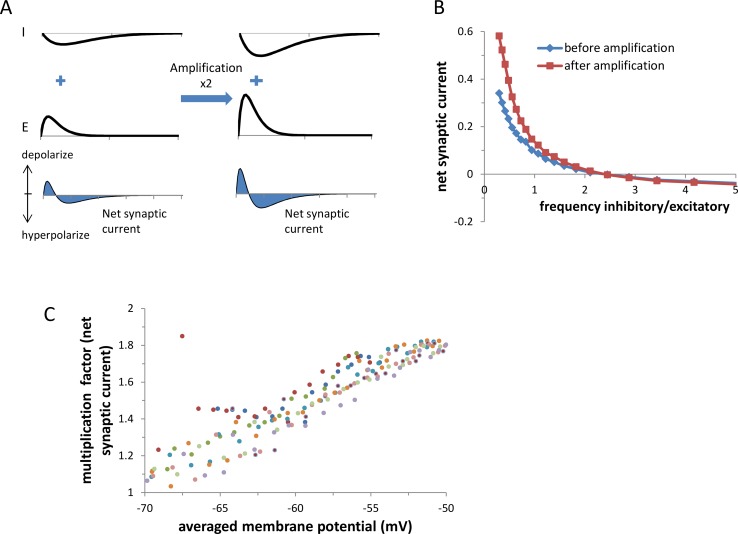
The amplification mechanism multiplied the net synaptic current.A. The net synaptic current is the sum of the inhibitory and excitatory currents. Multiplication of both the inhibitory (upper panel) and excitatory currents (middle panel) multiplies the net synaptic current (lower panel). Therefore, if the net synaptic current is positive this multiplication will further depolarize the cell and if negative will further hyperpolarize the cell. B. The ratio of the activation frequency of inhibitory to excitatory synapses was varied by decreasing the activation frequency of each inhibitory synapse from11Hz to 3Hz, and increasing the activation frequency of each excitatory synapses from2Hz to 10Hz by 0.5Hz (x-axis). Each point on the graph is the average of 10 simulations. The different ratios of activation frequencies (inhibitory activation frequency divided by the excitatory activation frequency x-axis) resulted in different net synaptic currents (y-axis). The amplification mechanism increased the net-synaptic current while maintaining its polarity. A significant multiplicative effect was mainly observed at positive net synaptic currents, thus primarily when the effect of the net synaptic current was excitatory. This figure is a result of one simulated cell. C. Multiplication factors of the net synaptic current as a function of the average membrane potential. The simulation protocol is as described in B, where each color indicates a different set of simulations (in total 10 different sets of simulations). The sets of simulations differed in terms of intrinsic characteristics (resting potential: -90 - -60 mV) and the average strength of the synapses (excit/inhib: 0.6–1.3). Each dot in a set of simulations is a result of a different activation frequency of the inhibitory and excitatory synapses, as was described in B.